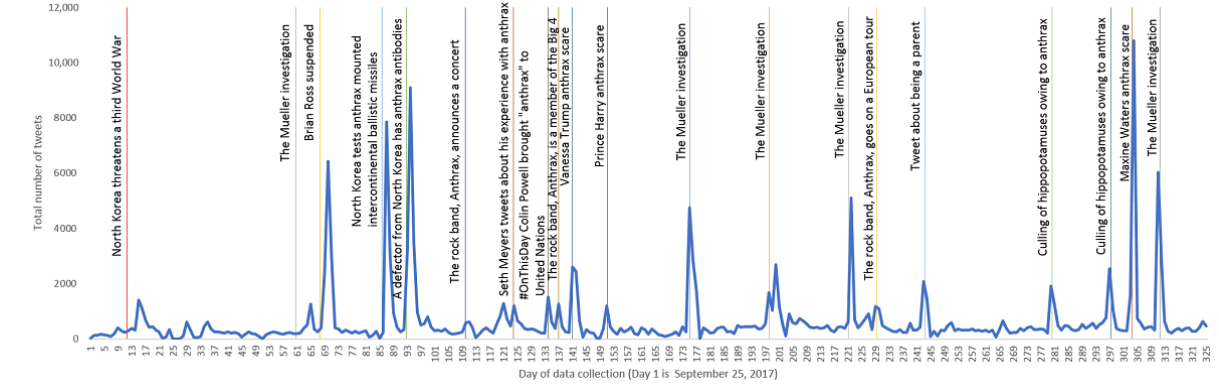
Figure 2. Line graph showing the number of tweets collected during each day of data collection (September 25, 2017, to August 15, 2018). Vertical lines indicate when news was first published about one of the detected anthrax-related